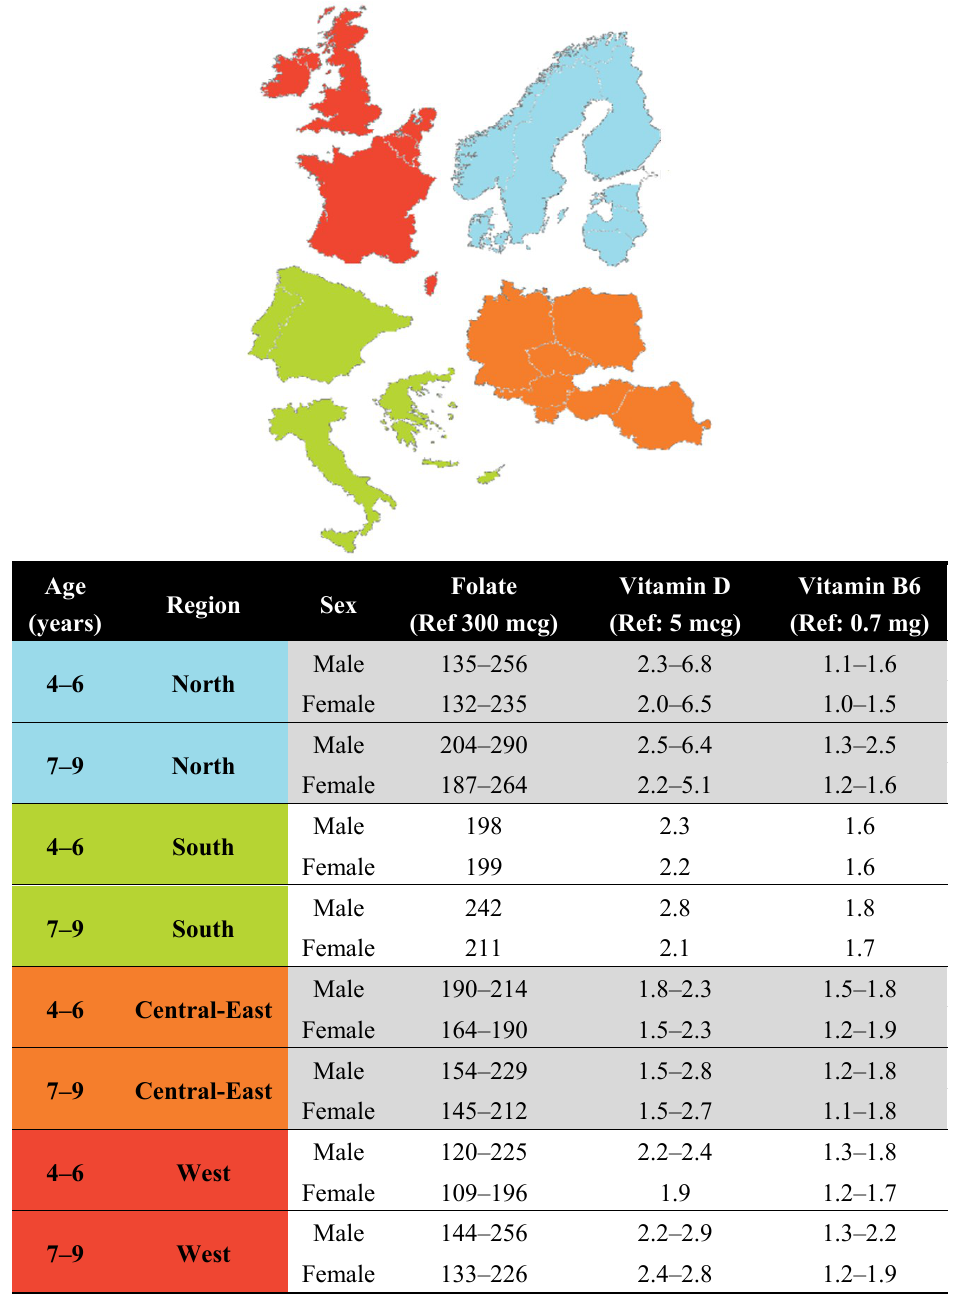
Figure 1. Folate and Vitamin D levels that fell below recommended reference values compared to normal ranges of Vitamin B6 levels in children in different regions of